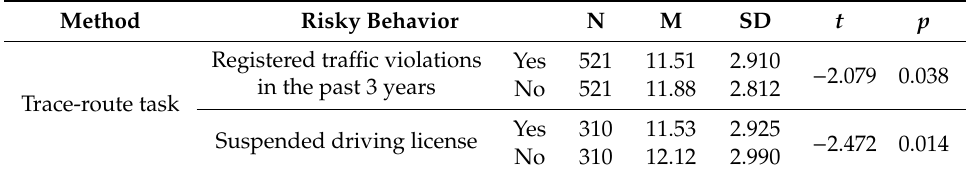
Table 6. Comparison of the groups with and without “tra ffi c violations in the past three years” / “suspended driving